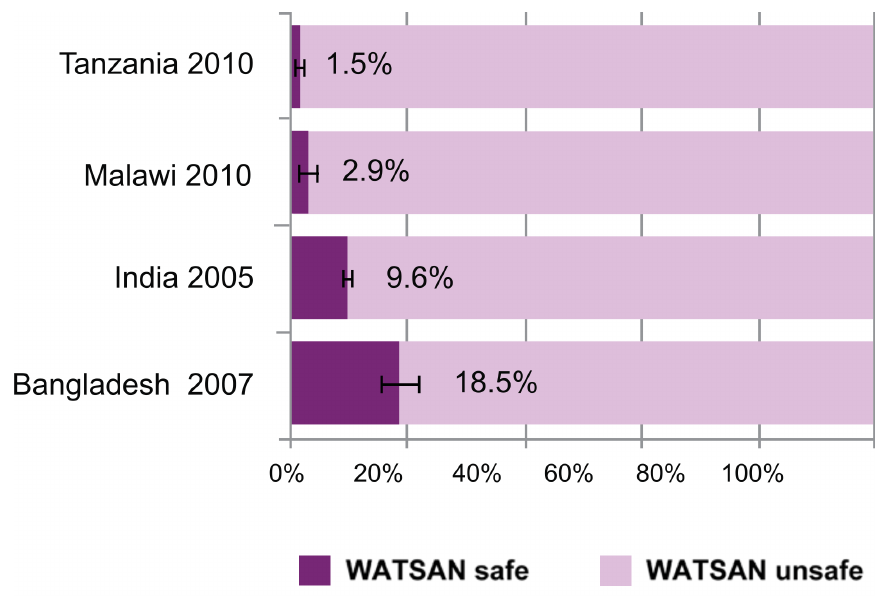
Figure 1. Proportions of births occurring in current household environments in the five years preceding the survey, by type of WATSAN environment. Error bars represent 95% confidence intervals of estimates. Definitions: Birth environments were defined as ‘‘WATSAN safe’’ or ‘‘WATSAN unsafe,’’ rather than ‘‘WASH safe’’/‘‘WASH unsafe.’’ WATSAN-safe was defined as the availability of and access to improved water sources and improved sanitation facilities, but not including hygiene practices, water quality, or consistency of availability. Source: Demographic and health surveys (DHS) data for the four countries shown (year of survey in parentheses); analysis as described by Benova and colleagues [30].